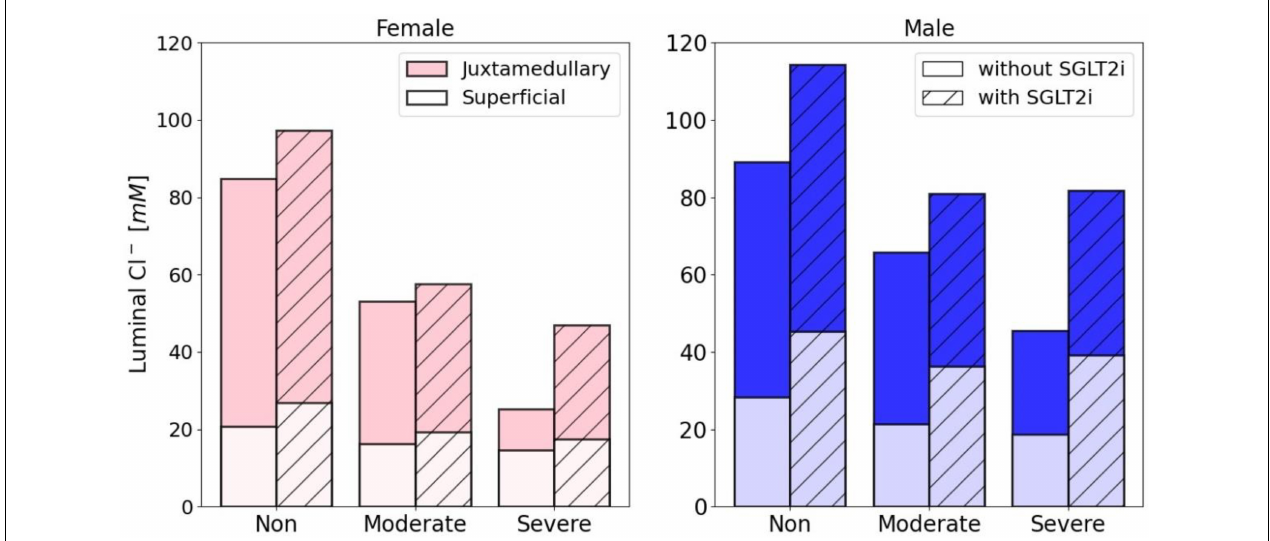
FIGURE 7 | Luminal [Cl − ] (mM) at the macula densa for non, moderately and severely diabetic women and men. The contribution from one superficial nephron and five juxtamedullary nephrons are both shown here. To calculate an average value, we would have to take a population weighted average of 85: 15 superficial: juxtamedullary. Note that the juxtamedullary values span the full y-value. For example, for non-diabetic women under no SGLT2 inhibition, the contribution from the juxtamedullary nephron is 84.9 mM.